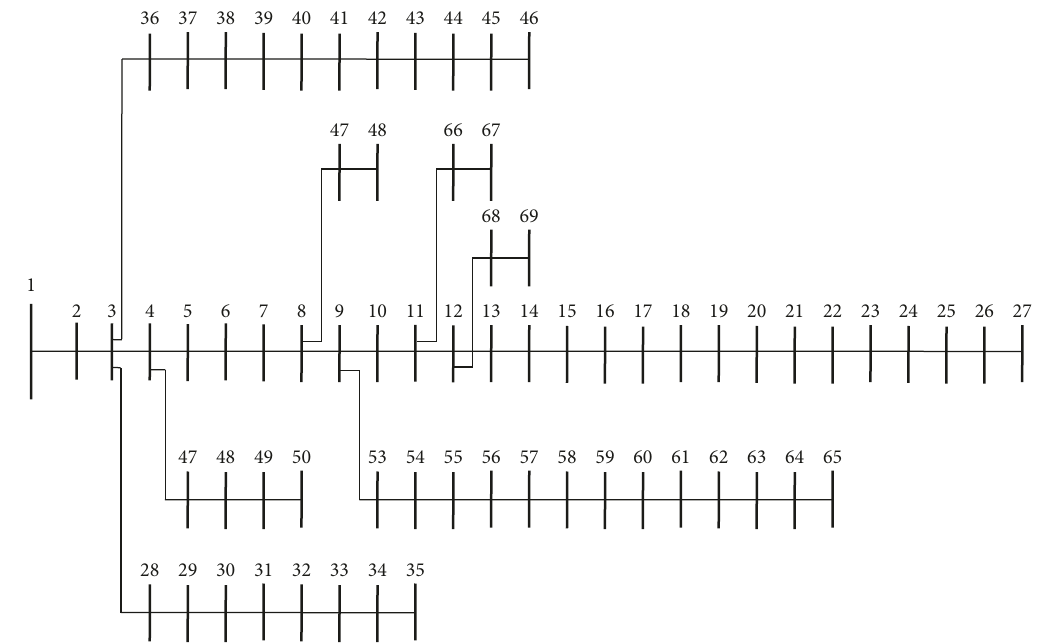
Figure 13: Single-phase diagram of IEEE 69 bus. Table 6: Results for IEEE 69-bus